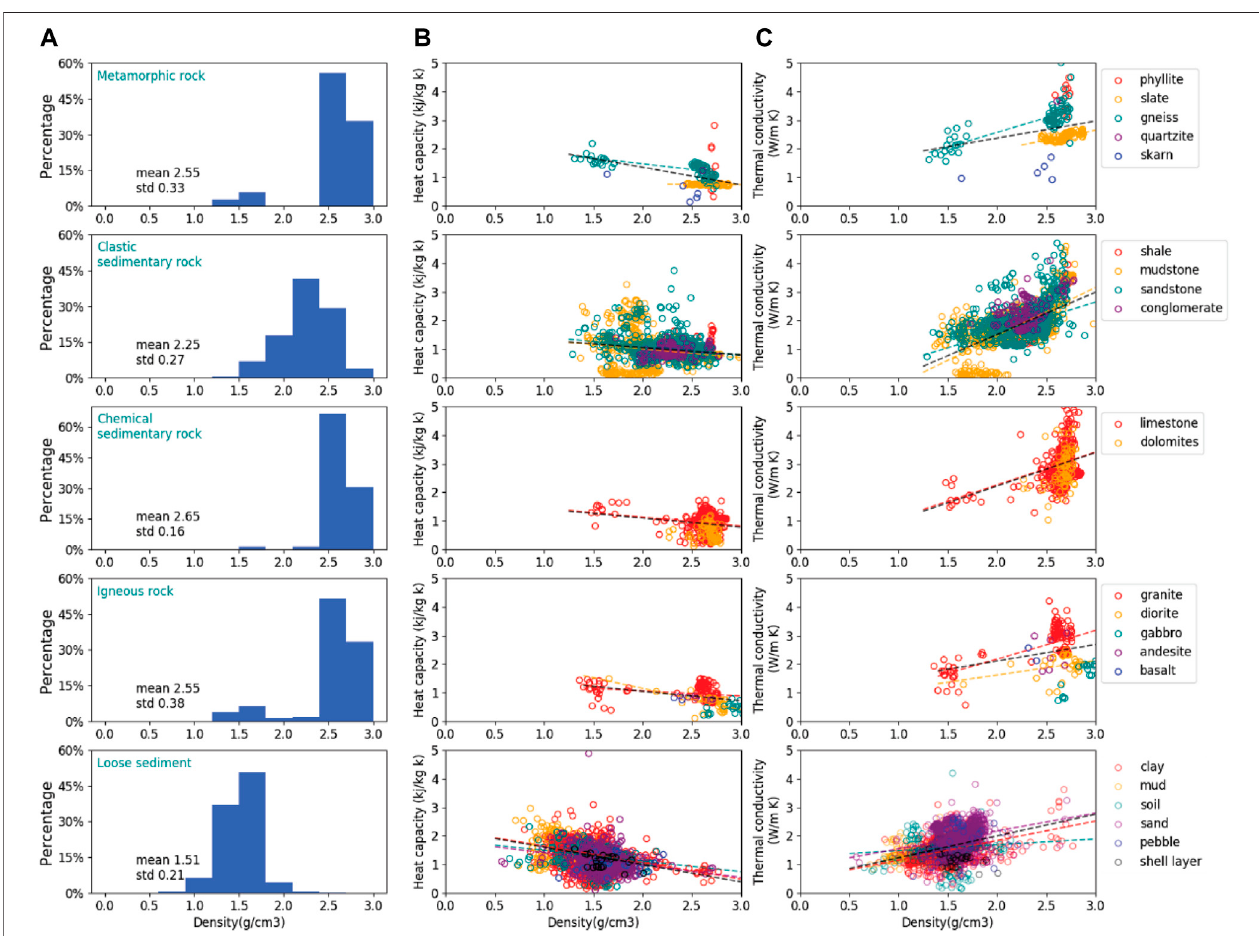
FIGURE 3 | Histograms of density (A) and its regression analysis with respect to heat capacity (B) and thermal conductivity (C) of rock and soil samples.